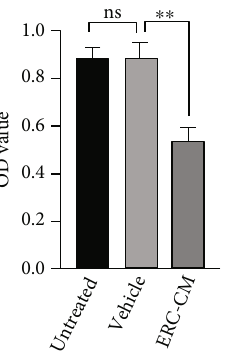
Figure 8: ERC-CM inhibits the proliferation of splenocytes in vitro . The proliferation of splenocytes in response to ConA was measured by using the CCK-8 kit. The p value was determined by one-way ANOVA. ∗ p < 0 : 05 , ∗∗ p < 0 : 01 , ∗∗∗ p < 0 : 001 , and ∗∗∗∗ p < 0 : 0001